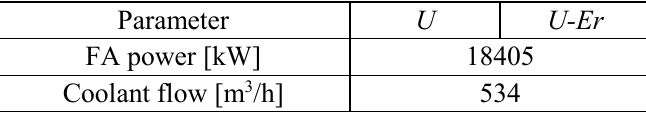
Table II: Main TH data. Details can be gathered from